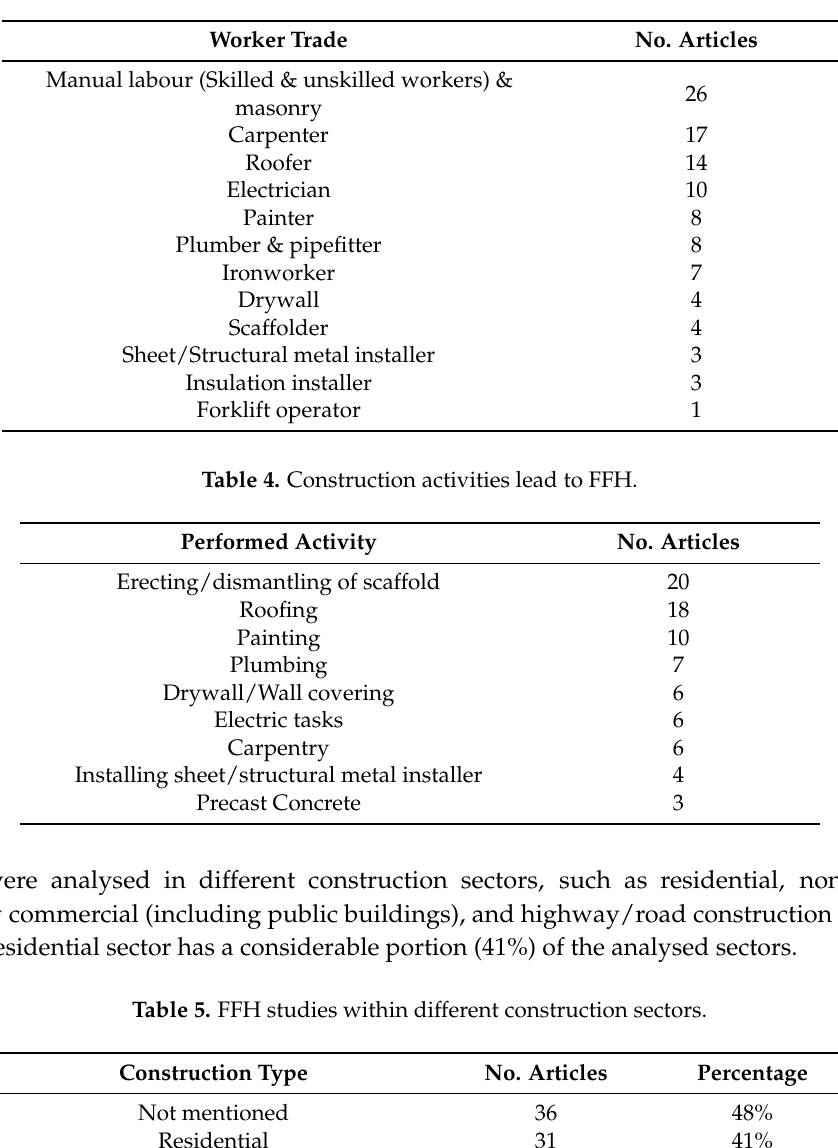
Table 3. Trades exposed to FFH.